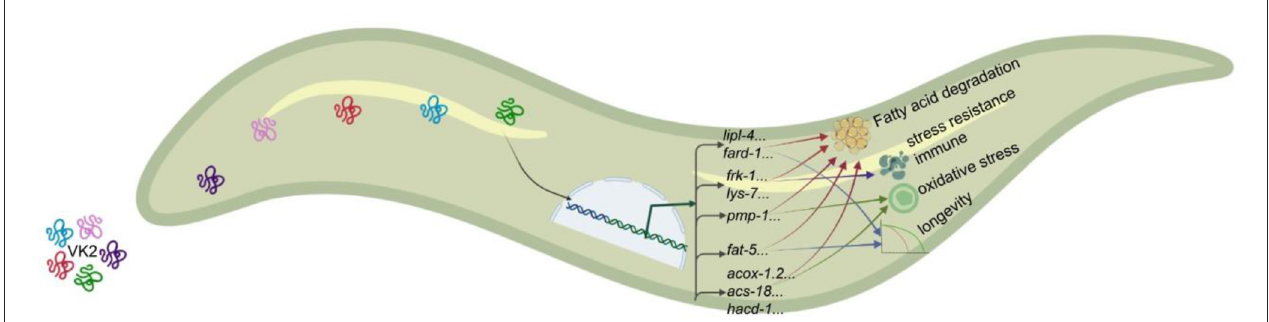
FIGURE 6 | VK2 mainly works via fat metabolism to improve the survival of worms. According to all the data, including RNA-seq and in vivo experiments, it was shown that the main function of VK2 involves enhancing fatty acid metabolism. VK2 treatment reduced the fat content in the worm body by activating gene expression involved in longevity, peroxisome, and immune and stress response pathways. However, it was found that almost all of these genes were related to fatty acid metabolism. All of the genes tested in these in vivo experiments function in fat metabolism to promote fatty acid digestion, and fatty acid β -oxidation in the peroxisome might play a primary role in VK2-improved fat reduction. As such, the genes induced by VK2 regulate fatty acid elongation, desaturation, and oxidation to promote digestion of fat content and, thus, support the survival of the